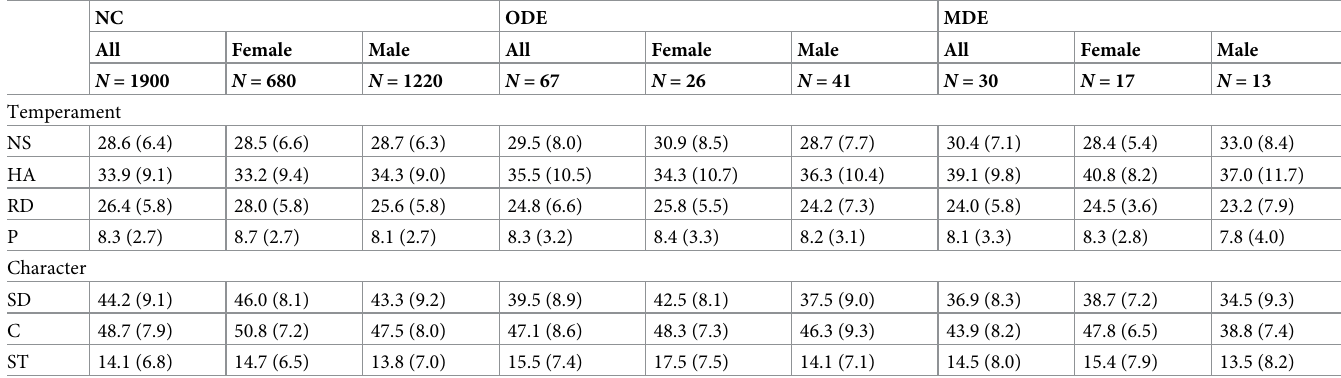
Table 2. Baseline TCI scores among NC, ODE, and